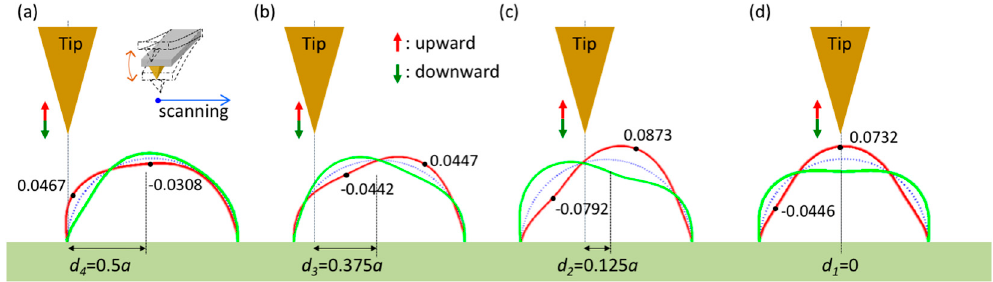
Figure 8. Vibrating amplitude of the specimen as the scanning tip approaches from a distance to the tip center (values are normalized by the factor [ π 4 η W 0 Pd 4 / ( 8 bEI )].